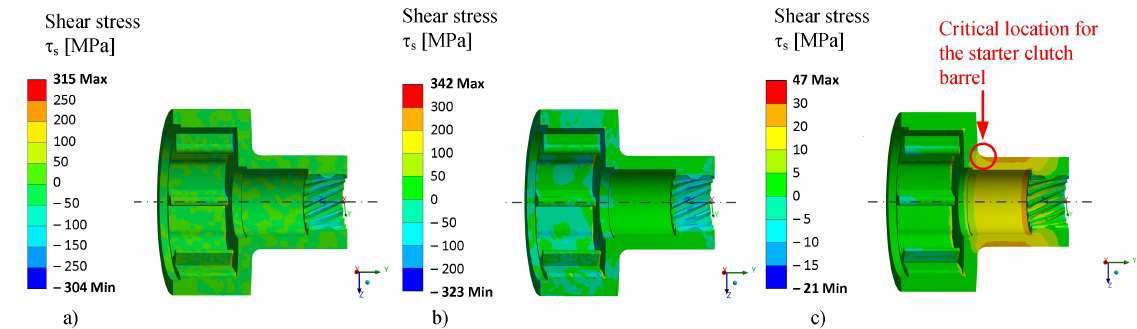
Figure 9. Shear stresses in the tangential-axial direction ( a ) after the heat treatment, ( b ) at the time of operation and ( c ) without the consideration of heat treatment at the time of operation.